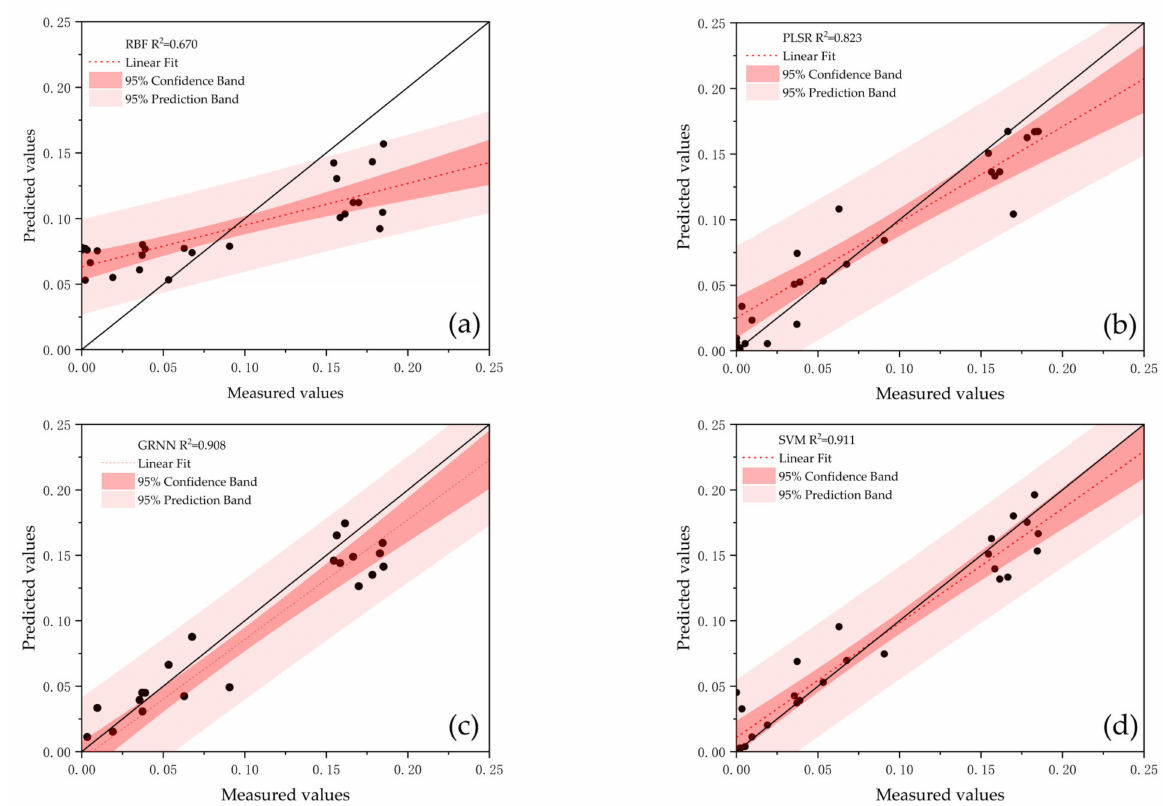
Figure 7. Model prediction of parallel polarization spectral data ( a ) RBF, ( b ) PLSR, ( c ) GRNN, ( d ) SVM. The measured values and predicted values are expressed as the copper grade of the test samples and the predicted value of the model. The black line shows the 1:1 relationship and the dashed line shows the model trend. In the data augmentation domain, the input spectra with ranges of 450–1700 nm for Copper grade were selected to develop multivariate regression models. The SVM model falls within the largest number of points within the 95% confidence